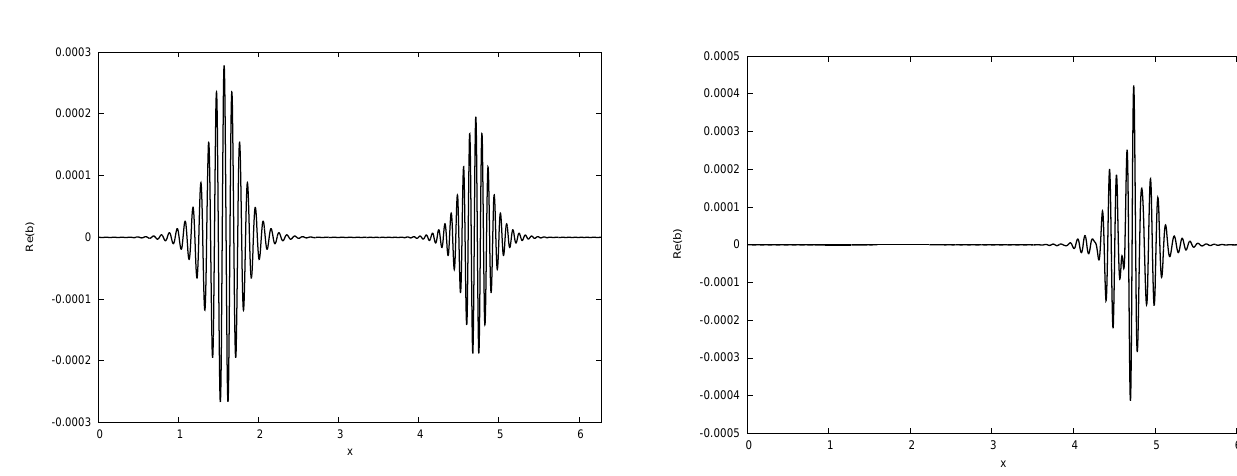
Fig. 6. Two breathers Figure 6. Two breathers collides. Figure 6. Two breathers collides. Figure 6. Two breathers collides. Figure 6. Two breathers collides.